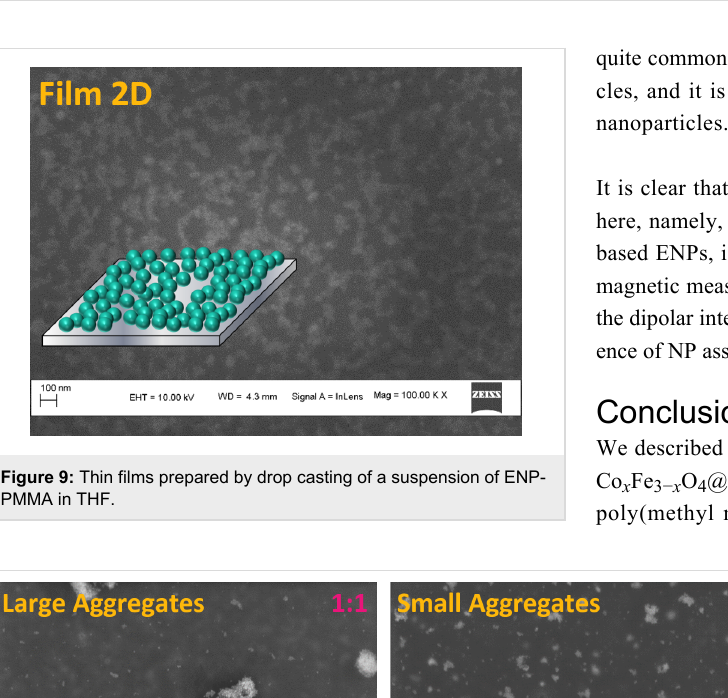
Figure 8: TEM images of magnetic ENPs decorated with PMMA brushes: (a,b) ENP-Br obtained through direct grafting of ATRP initiator after 3 h polymerization; (c,d) ENP-Br obtained by ligand exchange (oleic acid/ATRP initiator) under the same conditions.